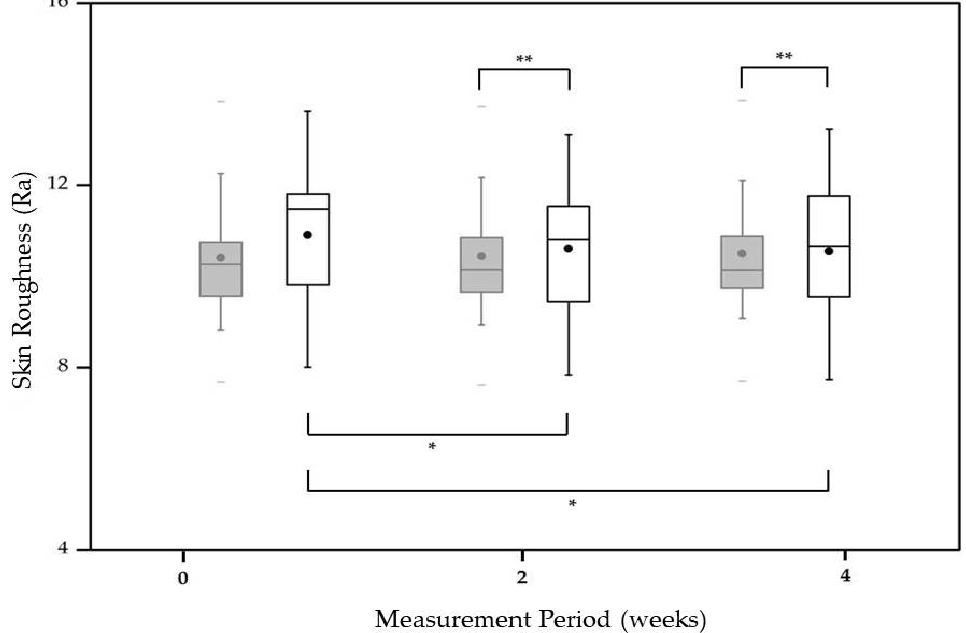
Figure 5. Skin roughness before (0 weeks) and after (2 and 4 weeks) using the collagen peptide buccal delivery film of the control group (gray) and test group (white). The boxplot shows the average (•), median ( ), and max–min whiskers ( I ). The changes were significantly different between the control and test groups, before and after intake, with p < 0.05 (*) and p < 0.01 (**).